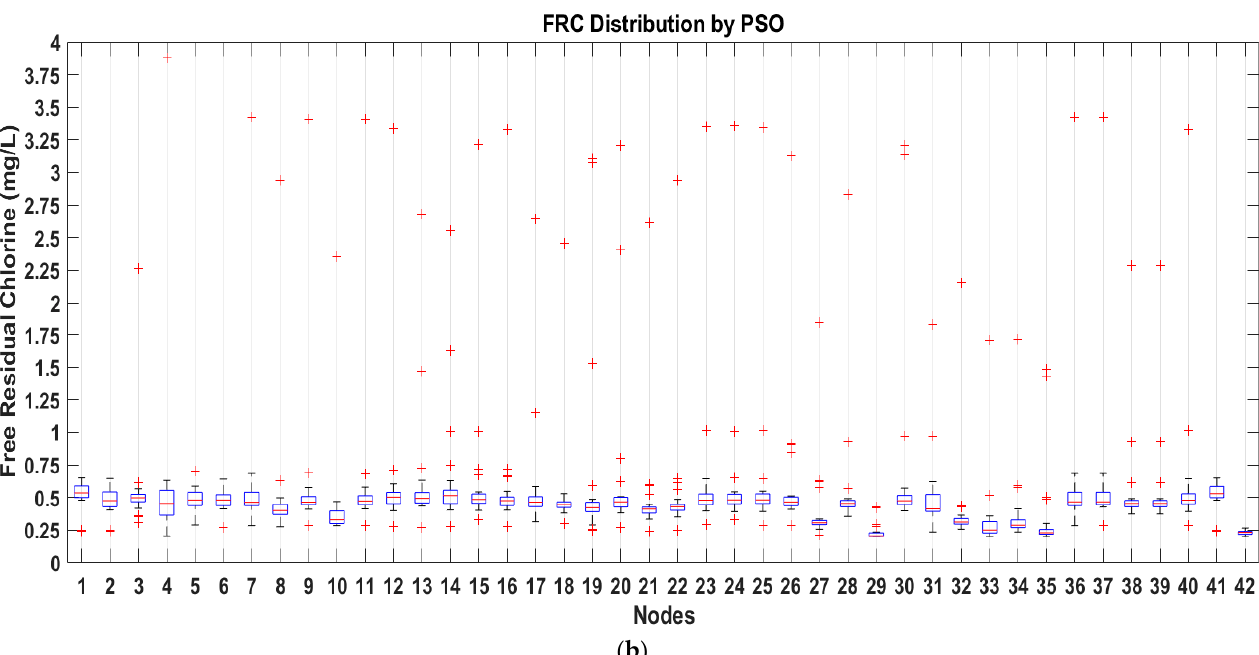
Figure 9. ( a ) FRC Distribution concentrations on the nodes of the WDN for the solution by GA. ( b ) FRC Distribution concentrations on the nodes of the WDN for the solution by PSO.